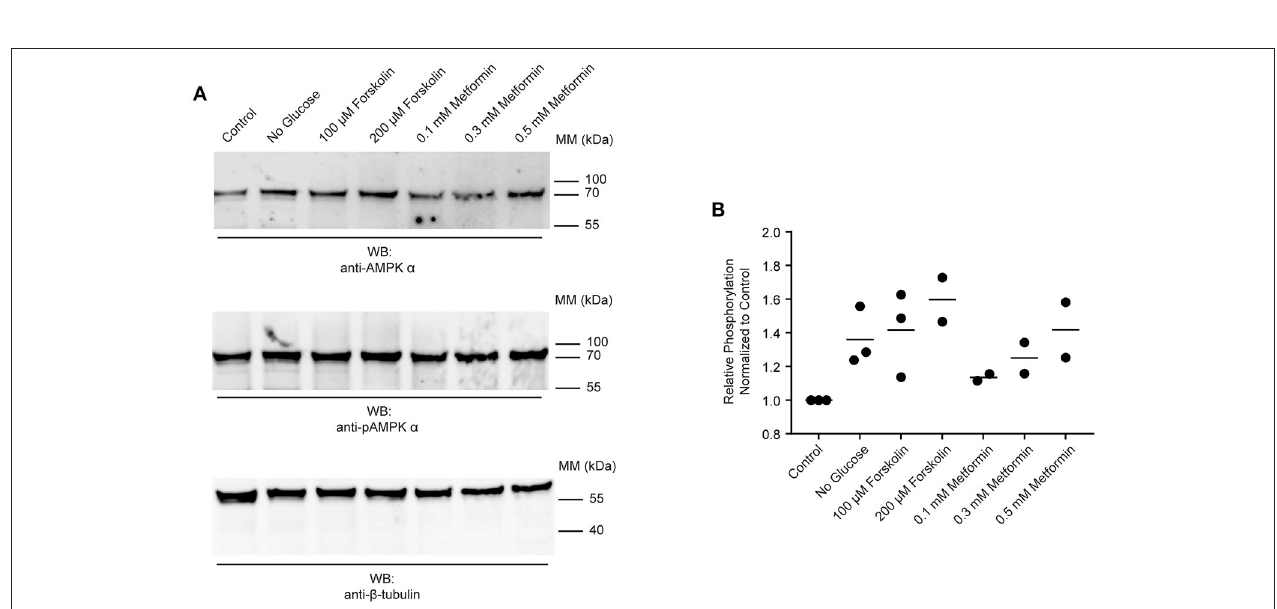
FIGURE 5 | Responsiveness of schistosome AMPK α to external factors. (A) Freshly isolated adult schistosomes were incubated in control medium, medium lacking glucose, or medium supplemented with various concentrations of forskolin or metformin. After 2h, lysates were prepared and equal amounts of protein were probed by Western blot, using anti-AMPK α antibody (top panel), anti-pAMPK α antibody (center panel), and anti- β -tubulin antibody (bottom panel). WB, indicates the antibody used for Western blotting; Positions of molecular mass (MM) markers, in kilodaltons (kDa), are indicated to the right of each blot. (B) Relative AMPK α phosphorylation under each condition was calculated by determining the ratio of the anti-pAMPK α signal to that of the anti-AMPK α signal, and then correcting for the intensity of the anti- β -tubulin signal. Relative AMPK α phosphorylation values were normalized relative those obtained with worms incubated in control medium. Data points from 2 to 3 independent biological replicates are